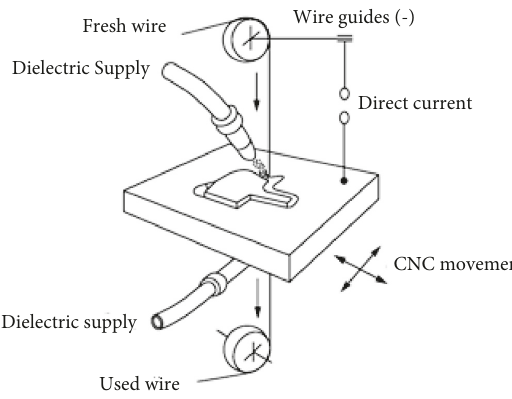
Figure 1: Schematic illustration of WEDM setup